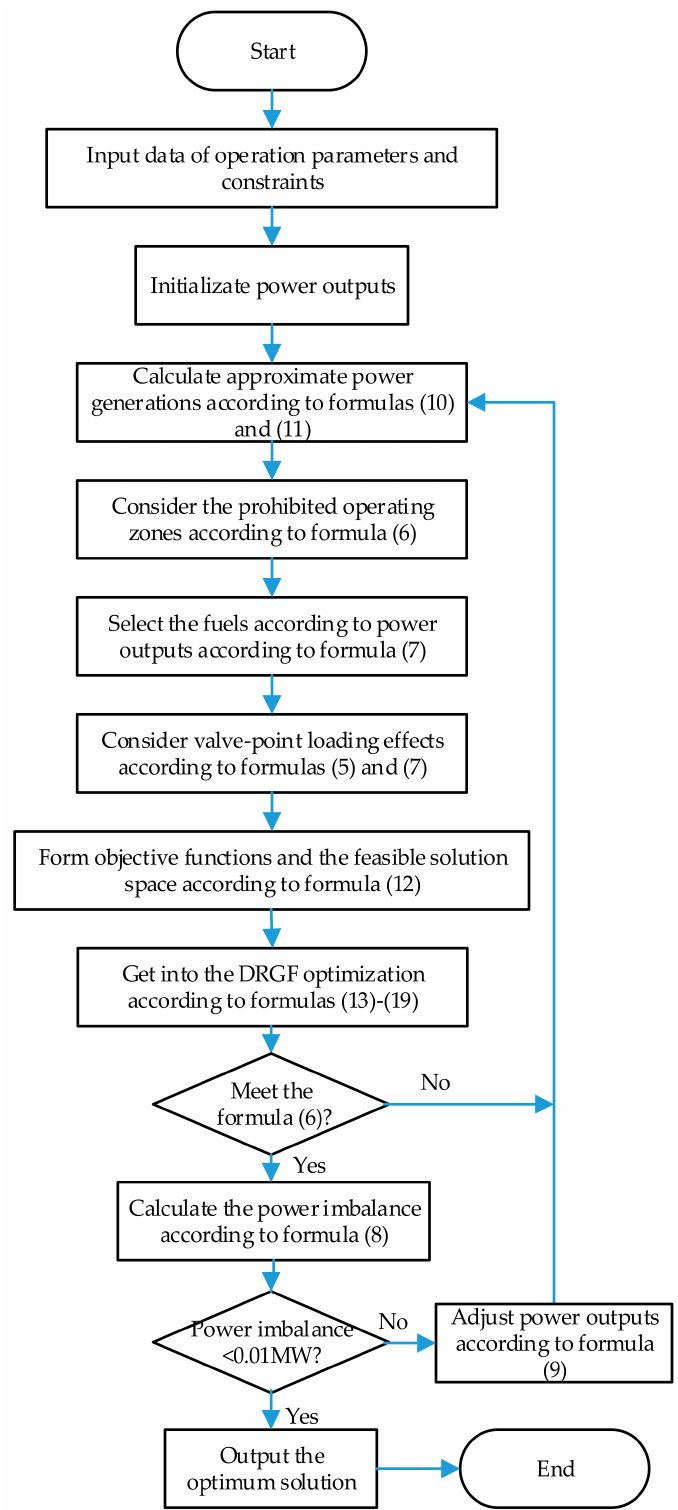
Figure 2. The non-convex economic dispatch process via the